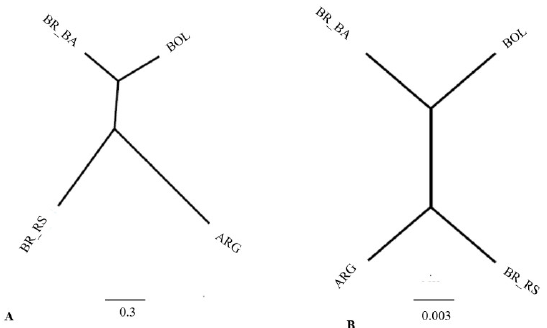
Figure 8. Dendrograms generated after generalized Procrustes analysis among populations from different regions. ( A ) Mahalanobis ( B ) Procrustes. ARG/Argentina (Córdoba) (TI25); ARG/Argentina (Santa Fé) (TI26); BA/Bahia/Brazil/Residual Foci (TI169); Bolivia/Cochabamba (TI165); RS/Rio Grande do Sul/Brazil (TI24, TI27, TI28, TI131, TI156 residual foci).